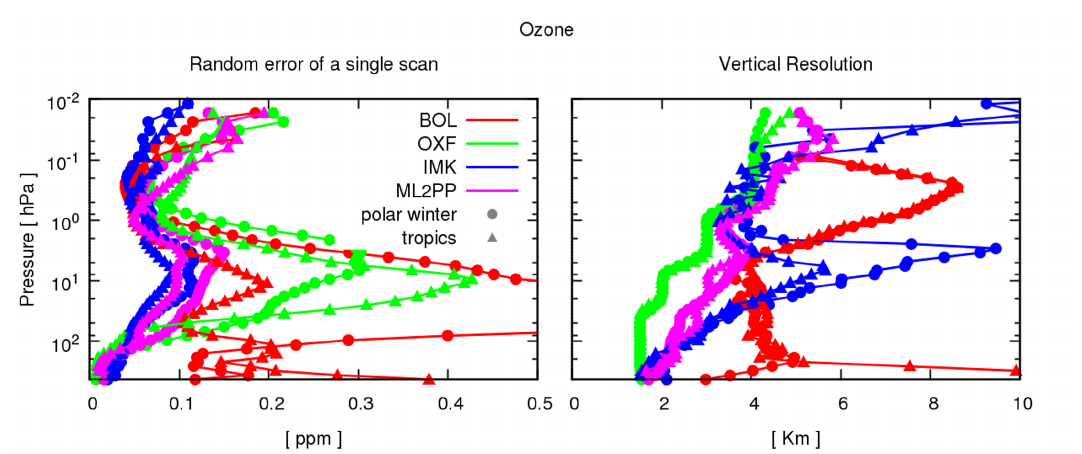
Figure 1: Ozone zonal means of single scan random error profile (left plot) and vertical resolution profile (right plot) of BOL (red curves), OXF (green curves), IMK (blue curves) and ML2PP (pink curves) for equatorial (curves with circles) and Southern hemisphere polar winter (curves with triangles)